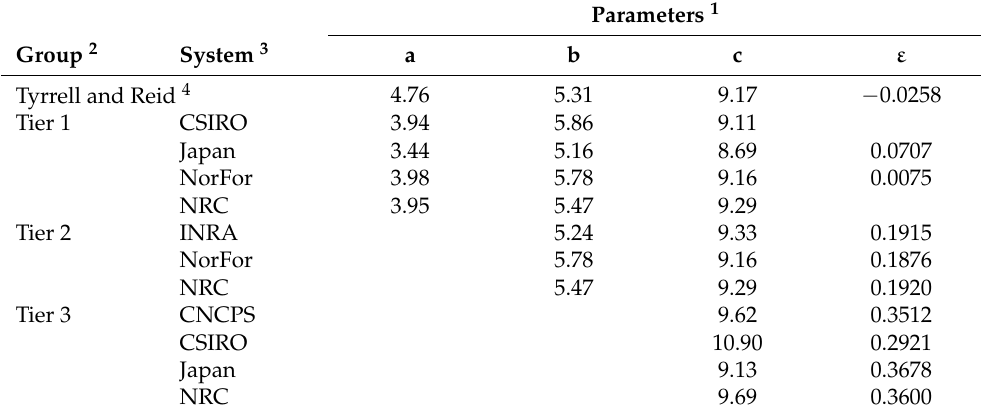
Table 2. Parameters of the equations to predict milk energy (Mcal/kg) according to the tiers.